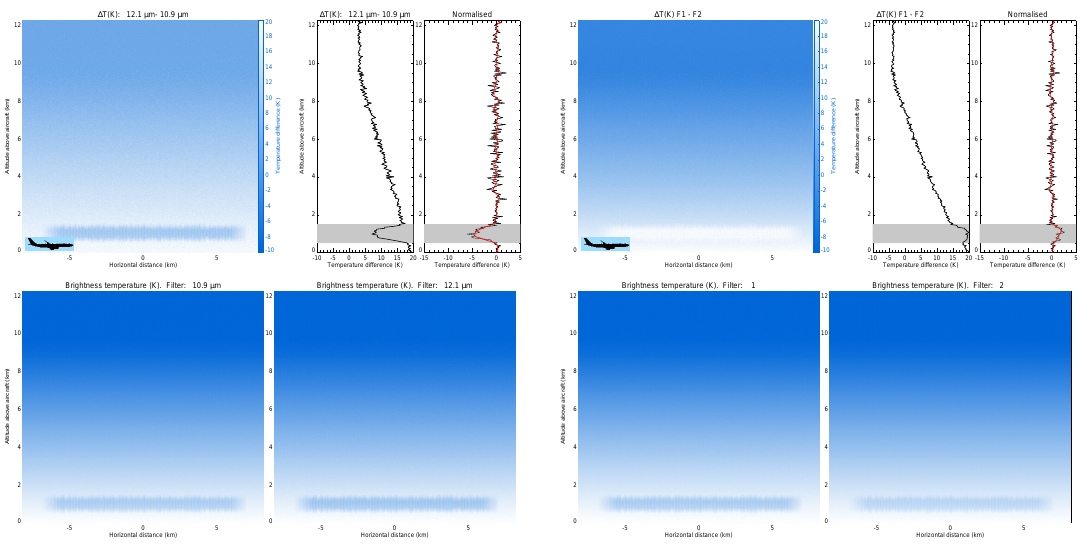
Figure 13. Left: Simulations for the standard set of filters for a water cloud ahead on an aircraft flying at 7 km ( 23,000 ft). The mean anomaly is –3 K and is of the same sign and magnitude as the signal obtained from an ash cloud. Right: The same scenario but using optimised filters. The anomaly is now positive and can be discriminated from an ash cloud.